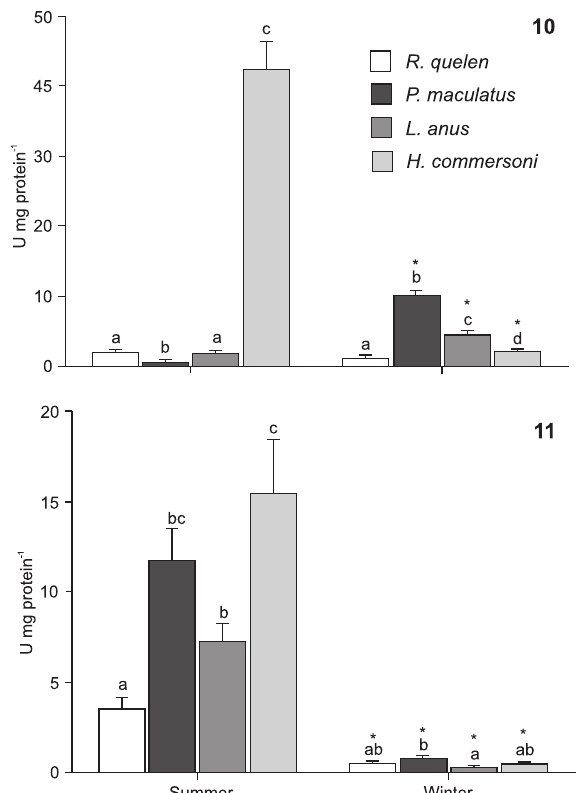
Figures 10–11. Lipase activity in the omnivorous R. quelen and P. maculatus and detritivorous L. anus and H. commersoni in the summer and winter: (10) anterior intestine; (11) posterior intestine. Different letters indicate significant differences between species in the same season. * Indicates a significant difference from the summer in the same segment (p < 0.05). (U, a Caraway unit) (n = 15 from each species at each